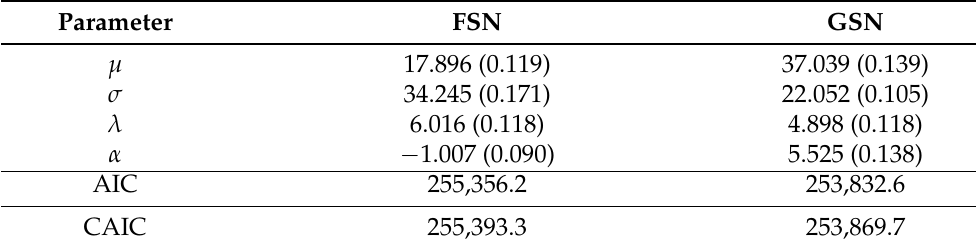
Table 8. Parameter estimates (SE) for FSN and GSN